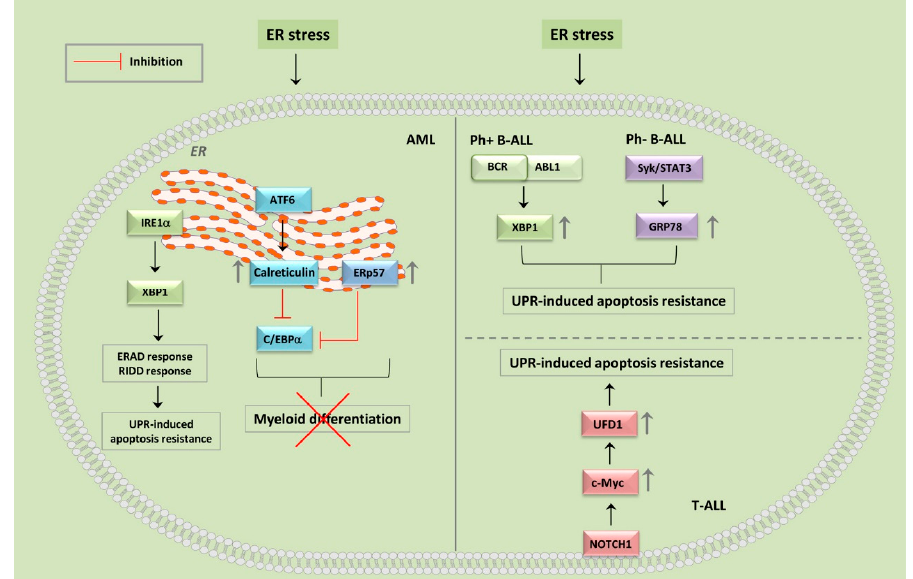
Figure 2. Involvement of unfolded protein response (UPR) in acute myelogenous leukemia (AML) and acute lymphoblastic leukemia (ALL). In AML cells (left panel), Inositol-requiring enzyme- 1 α ( IRA1 α) /X-box binding protein 1 (XBP1) enhanced signaling leads to